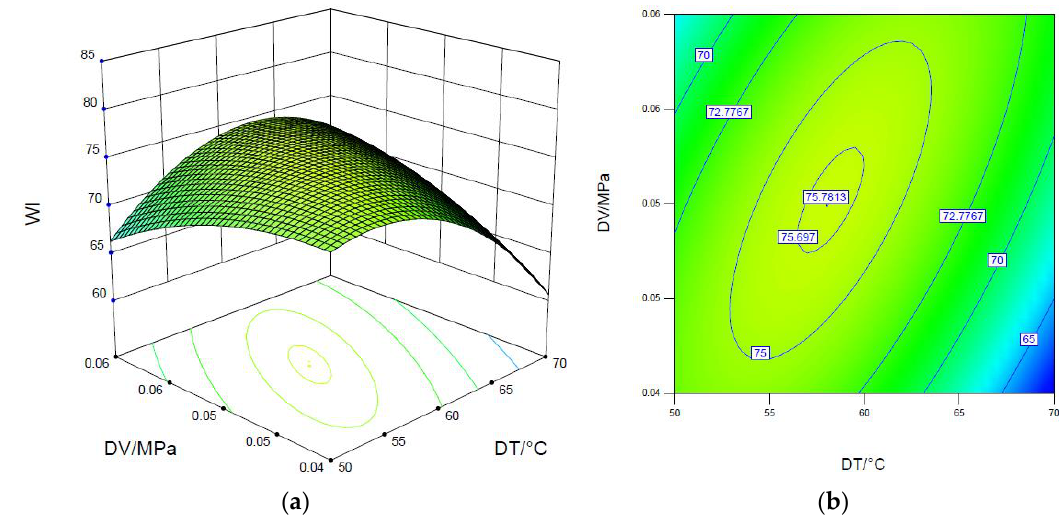
Figure 8. Response surface ( a ) and contour ( b ) for W with respect to interaction term of DT•DV at a constant MT of 2 mm.